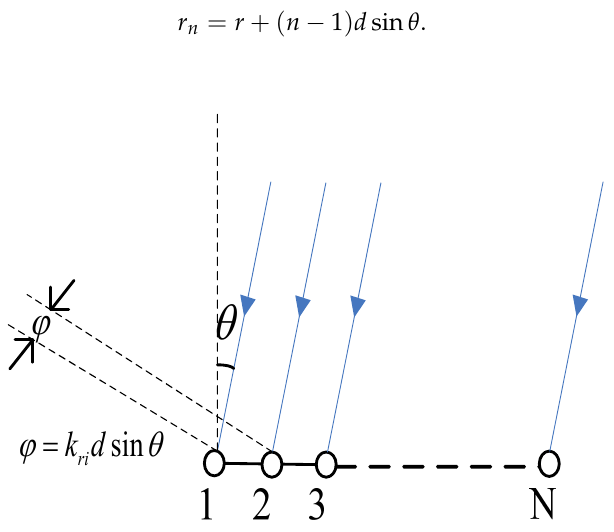
Figure 1. Phase difference normal mode i ; is the azimuth of the source.